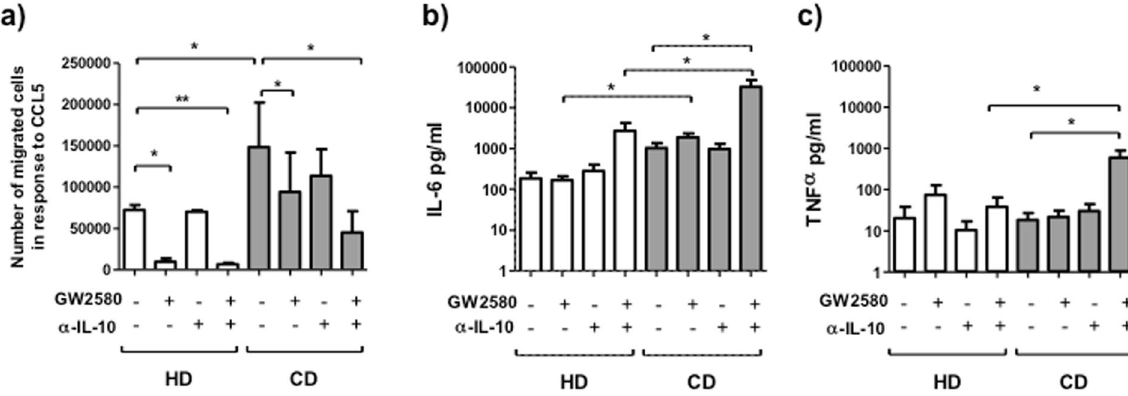
Figure 3. Functional effects of CSF-1 and IL-10 on peripheral blood monocytes from HD and CD patients in remission. ( a ) Peripheral blood monocytes from HD (n = 4) and inactive CD patients (n = 6) after 24 h of culture with medium, GW2580 (35 ng/ml), anti-IL-10 (3.5 ng/ml), or GW2580 + anti-IL-10 were subjected to a 4h-chemotaxis assay toward CCL5. The cells that had migrated into the lower chamber were collected and stained with anti-CD14 and analyzed by flow cytometry. The results are expressed as the mean of the number of CD14 + migrated cells. ( b , c ) The levels of IL-6 and TNF- α in the supernatant of the 24h-culture of peripheral blood monocytes from HD and inactive CD in the presence of medium, GW2580 (35 ng/ml), anti-IL-10 (3.5 ng/ml), or GW2580 + anti-IL-10 were quantified by ELISA. Multiple comparisons of HD and CD were calculated by ANOVA (migrated cells HD: p < 0.0001 and CD: p = 0.05; IL-6 concentration in HD: p = 0.10 and CD: p = 0.09; TNF- α concentration in HD: p = 0.30 and CD: p = 0.05). The Mann-Whitney U test was used for comparison of HD and CD in each culture condition, and Wilcoxon test was used for the comparison between medium and each culture in HD and in CD ( * p < 0.05, ** p <